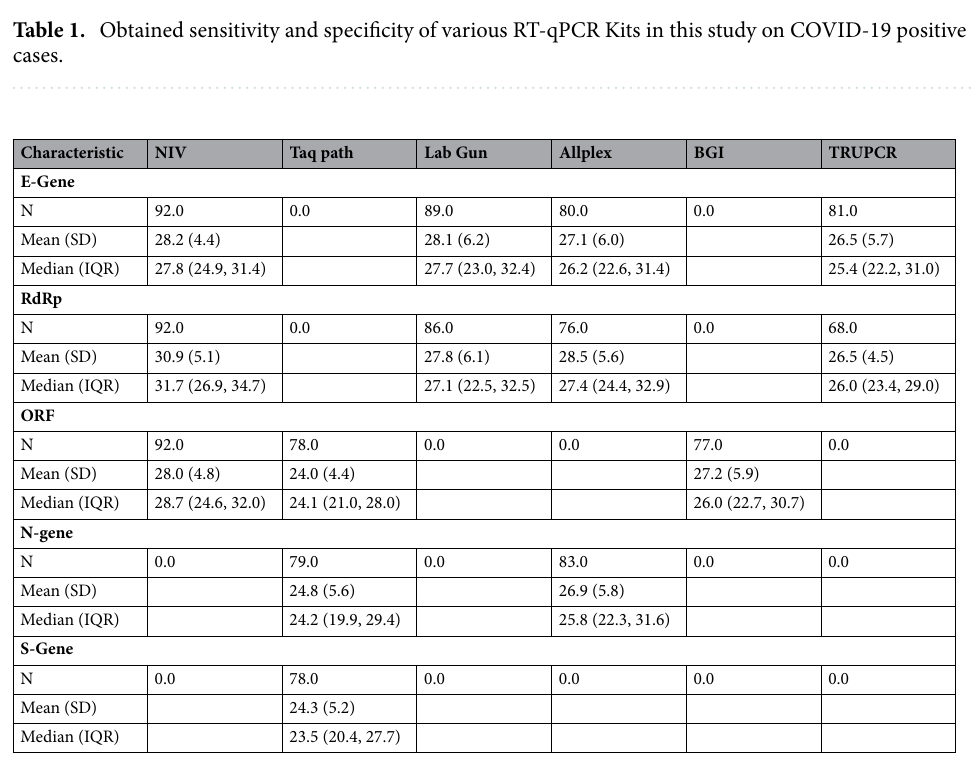
Table 2. Ct values estimated by different kits using mean and SD as well as median and interquartile